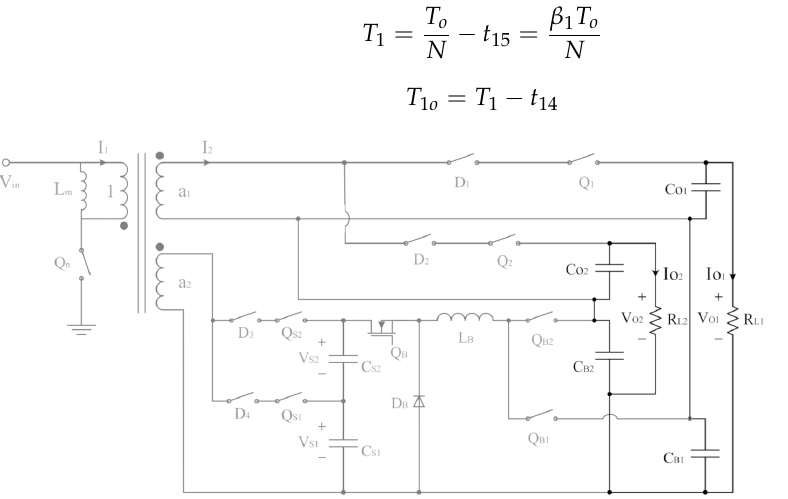
Figure 9. Equivalent circuits of the proposed SIMO power supply within